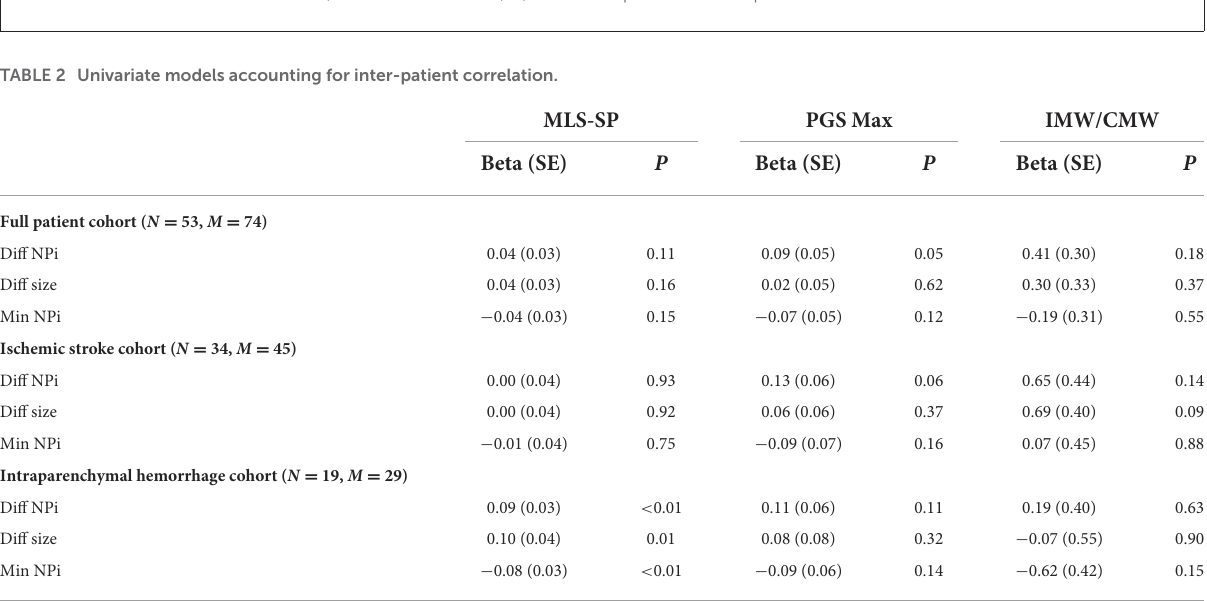
FIGURE2 Inclusion and exclusion flow chart. M, Number of head CTs; N, Number of patients. *Some patients meet more than one exclusion criteria.